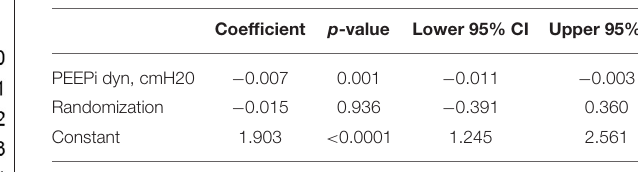
TABLE 3 | Association between the E/A ratio and dynamic hyperinflation, adjusted for